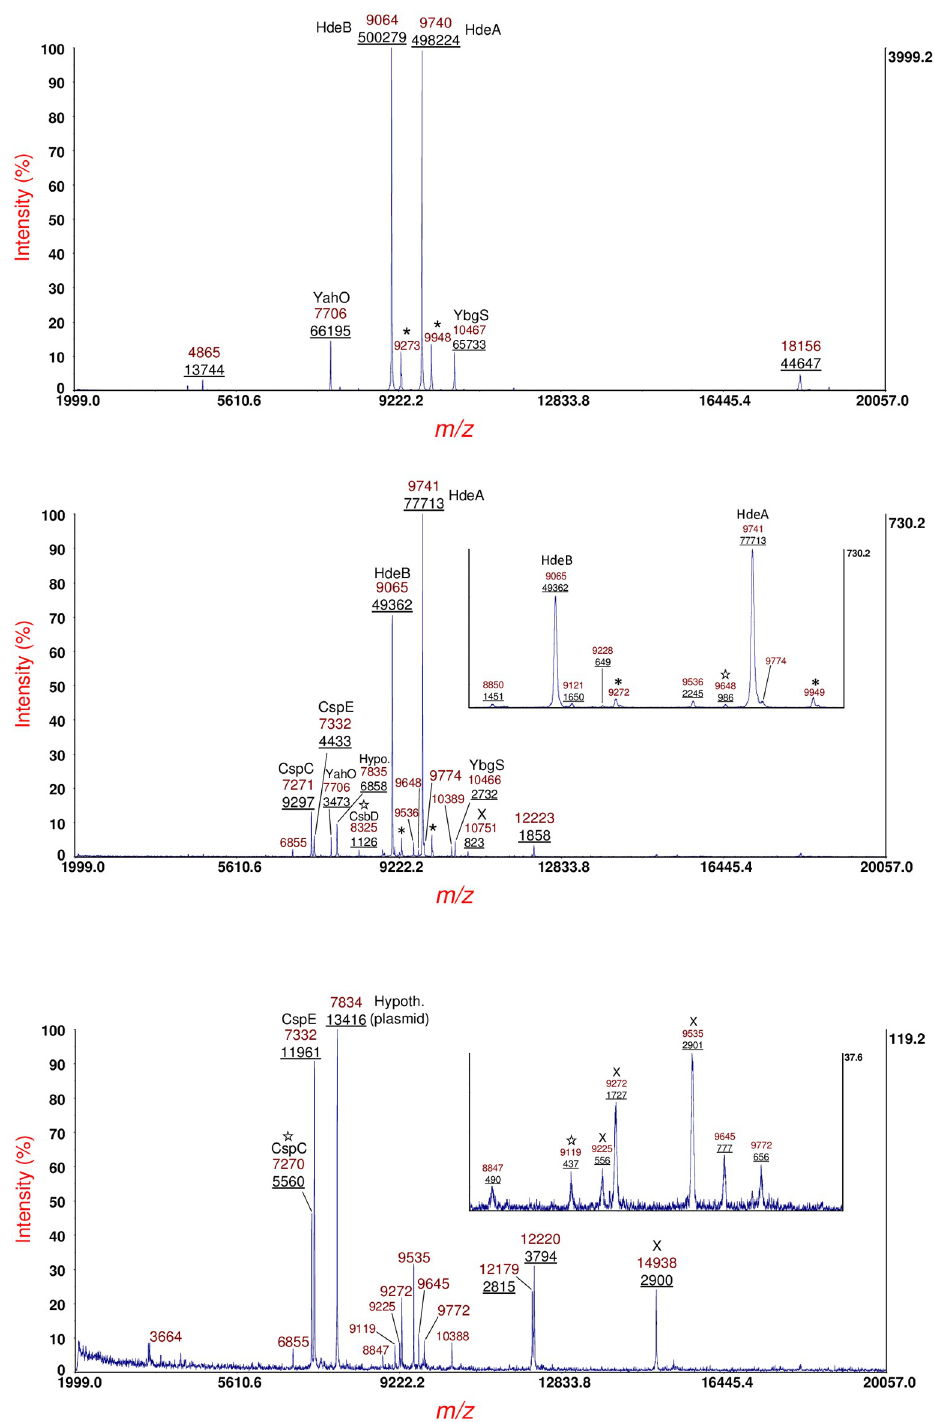
Fig 2. Top panel: MS of sample supernatant of E . coli O113:H21 strain RM7806 cultured overnight on LBA. Middle panel: MS of sample supernatant of strain cultured overnight on LBA supplemented with 400 ng/mL of MMC. Bottom panel: MS of sample supernatant of strain cultured overnight on LBA supplemented 600 ng/mL of MMC. Prominent protein ions are identified by the mass-to-charge ( m/z ) ratio. Integrated peak areas (underlined) are provided below the m/z . Expanded m/z are provided by inserts. Conserved proteins ions are labeled on the basis of previous identifications in other E . coli strains. Protein ions marked with an asterisk are MALDI matrix adducts. Protein ions marked with a star were analyzed by MS/MS in the current work. Protein ions marked with an X were analyzed by MS/MS, but the data was not of sufficient quality for an identification.